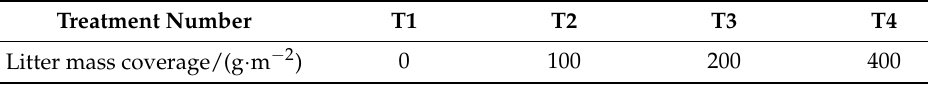
Table 2. Litter mass of Pinus massoniana for each treatment.